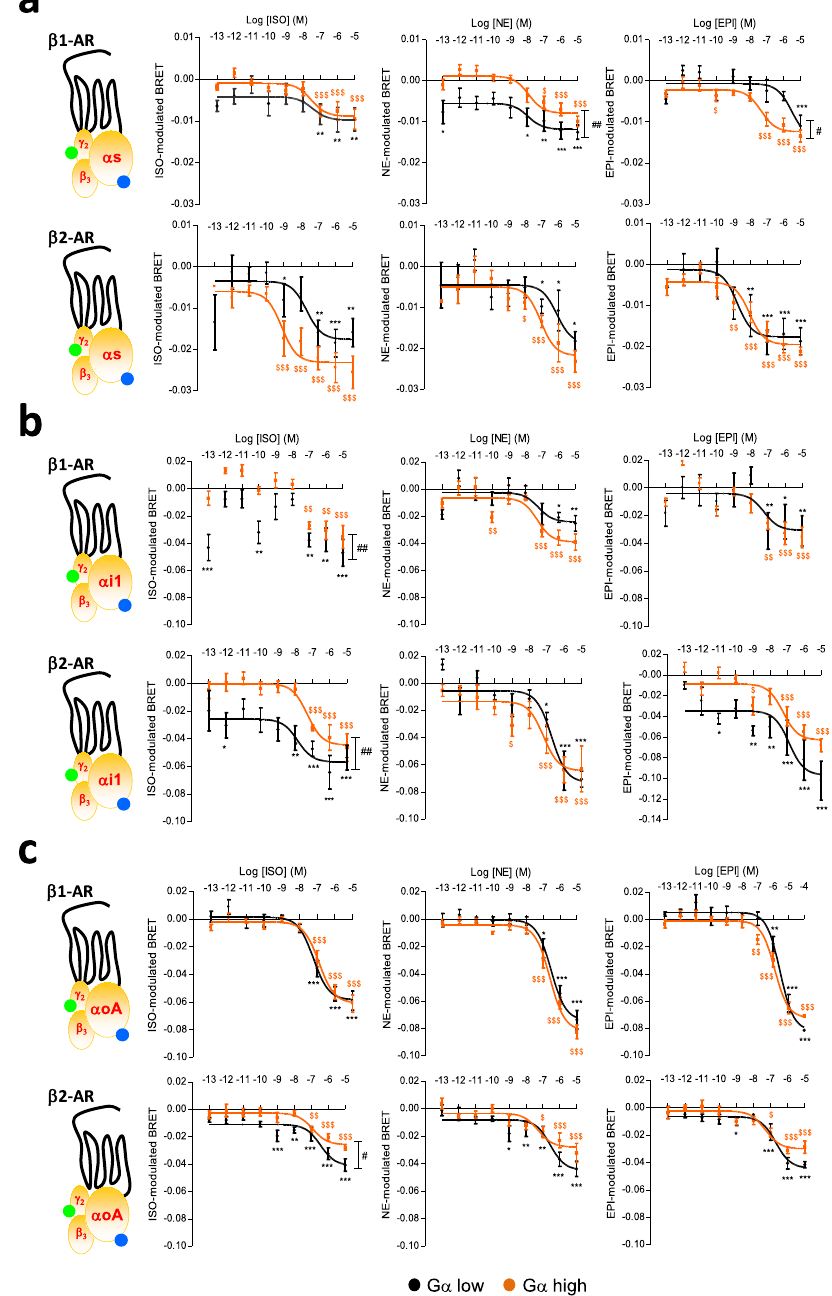
Figure 3. Influence of the G α subunit expression level on the concentration-response curves of β -AR agonists- mediated G protein activation. ( a – c ) BRET in HEK293T cells co-expressing HA- β 1-AR (upper panels) or HA- β 2-AR (lower panels) receptors and low (black) or high (orange) expression levels of G α s-Rluc8 ( a ), G α i1-Rluc8 ( b ) or G α oA-Rluc8 ( c ) in presence of fixed GFP10-G γ 2 and G β 3 untagged subunits. Cells were stimulated or not for 1 min with increasing concentrations of the indicated agonists (Isoproterenol, ISO; Norepinephrine, NE; Epinephrine, EPI). Results are expressed as the difference in BRET signals measured in presence and absence of ligand. Data represent the mean ± s.e.m. of at least four independent experiments. The statistical significance between unstimulated cells and cells stimulated with the different ligand concentrations in low ( * ) and high ($) G α -Rluc8 conditions was assessed using one-way ANOVA followed by a Dunnett’s multiple comparison test ( * P < 0.05, ** P < 0.01, *** P < 0.001). The statistical significance between low and high dose-response curves was assessed using two-way ANOVA followed by a Bonferroni post-test ( # P < 0.05, ## P <